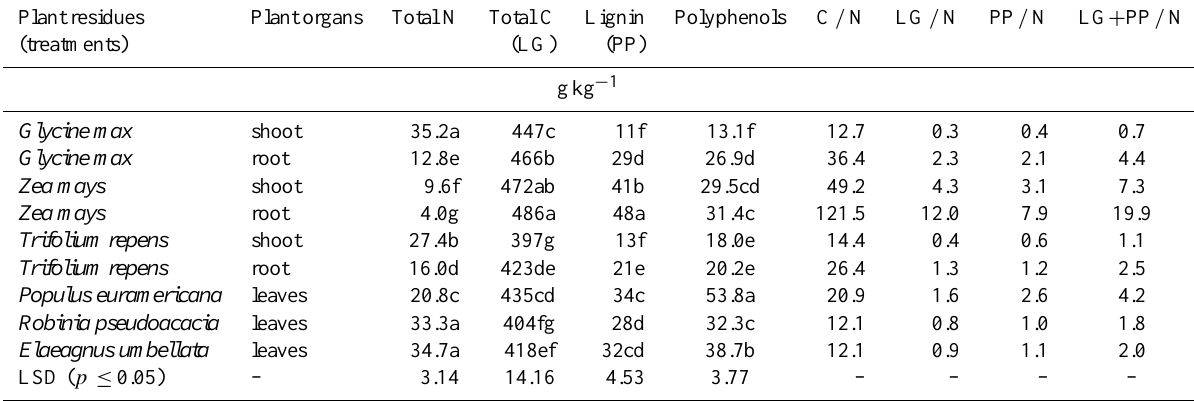
Table 2. Mean biochemical composition of the plant residues used in the experiment ( n = 3). Plant residues Plant organs Total N Total C Lignin Polyphenols C / N LG / N PP / N LG + PP / N (treatments) (LG) (PP) gkg − 1 shoot